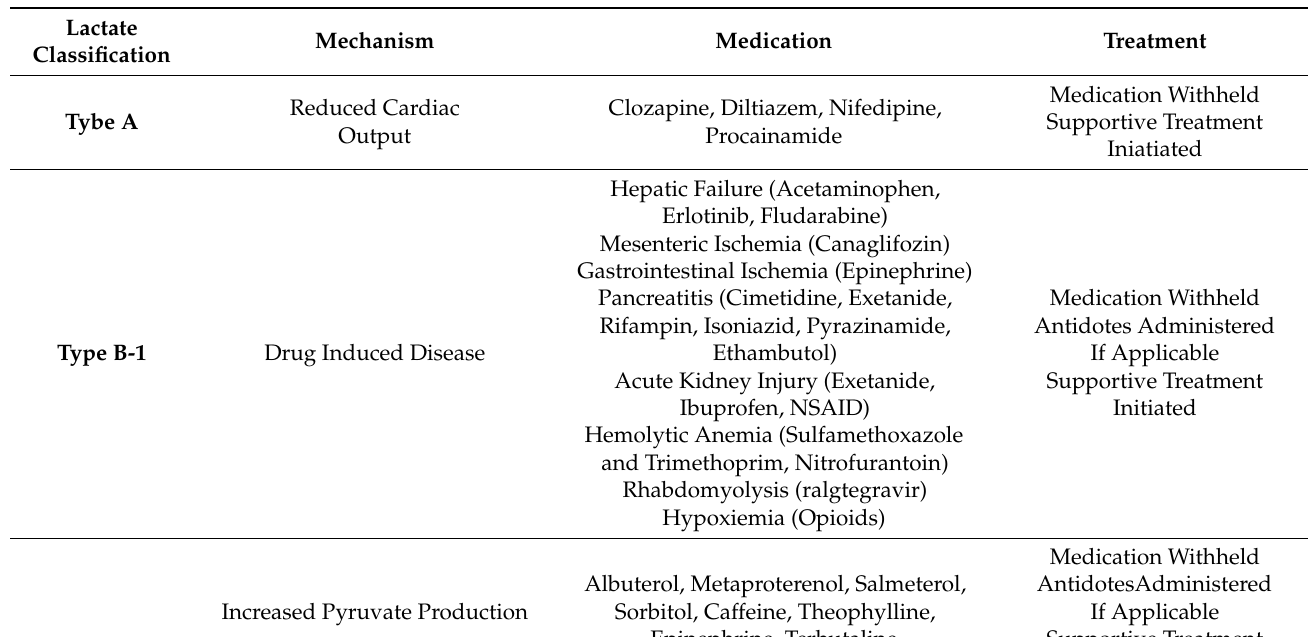
Table 1. Drugs Induced Lactic